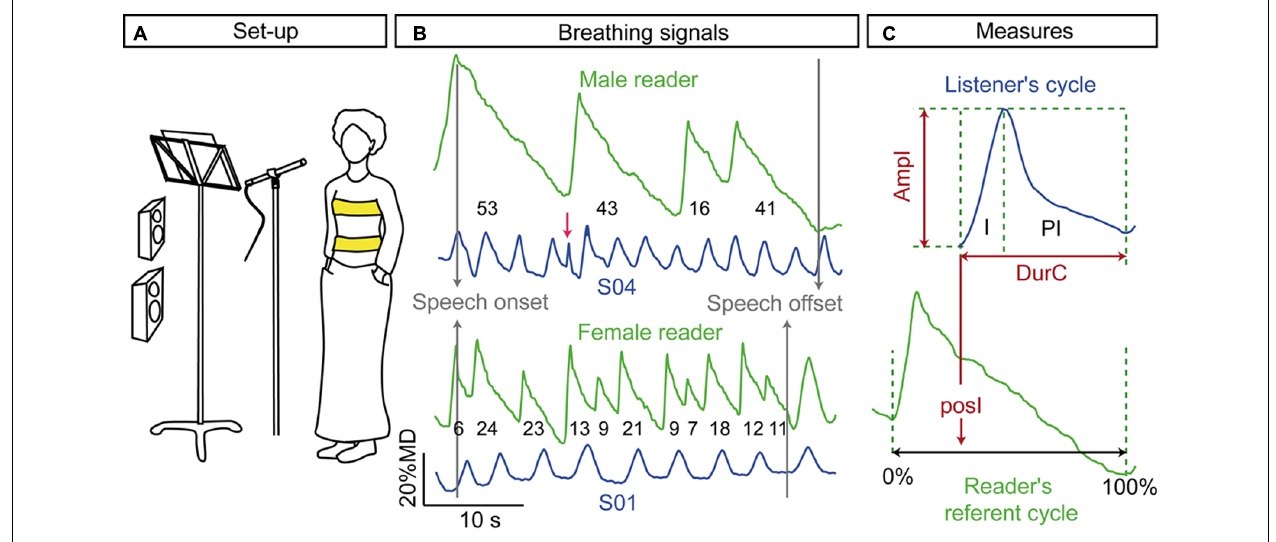
peak indicated by the red arrow were discarded; (C) the inhalation ( I ) and post-inhalation phase ( PI ) of the breathing cycle were labeled to measure the amplitude ( ampI ) and the duration ( durI ) of the breathing cycle.The onset of listener cycle inhalation was positioned relatively to the closest reader’s cycle, normalized between 0 and 100% ( posI